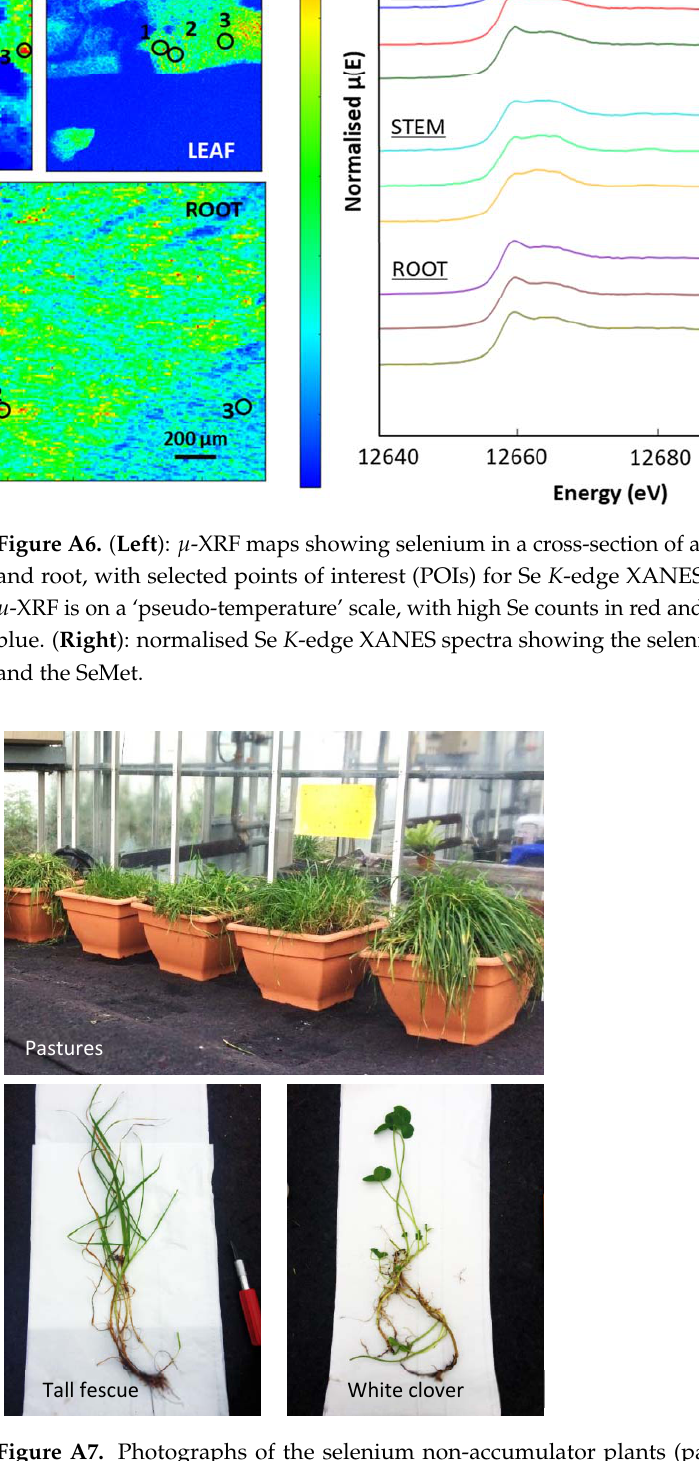
Figure A7. Photographs of the selenium non-accumulator plants (pasture species) collected for sampling for chemical and XAS analyses. Samples of tall fescue grass with minor necrosis of the leaves and white clover.